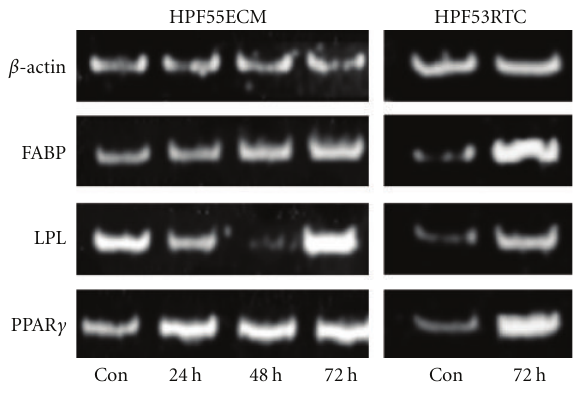
Figure 5: PCR Analysis of lipid metabolism proteins. PCR analysis was carried out on two individual isolates of hPFC cells under control conditions (con) and after 24h, 48 h, and 72h ciglita- zone treatment at 3.3 μ M ciglitazone for HPF55ECM cells, and control and 72 h ciglitazone at 3.3 μ M for HPF53RTC cells. For normalisation, β -actin was amplified. Fatty acid binding protein (FABP) showed a steady rise in expression over 24–72 h being highest at 72 h. Lipoprotein lipase was induced after 72h of ciglitazone treatment though mRNA levels showed high variations, even under control conditions between isolates. PPAR γ was induced at mRNA level after 24 h of treatment and highest after 72 h for both samples tested. PCR analysis shows the di ff erences between individual isolates of hPFC, while the general responsiveness towards ciglitazone treatment was similar, basal expression and induction values